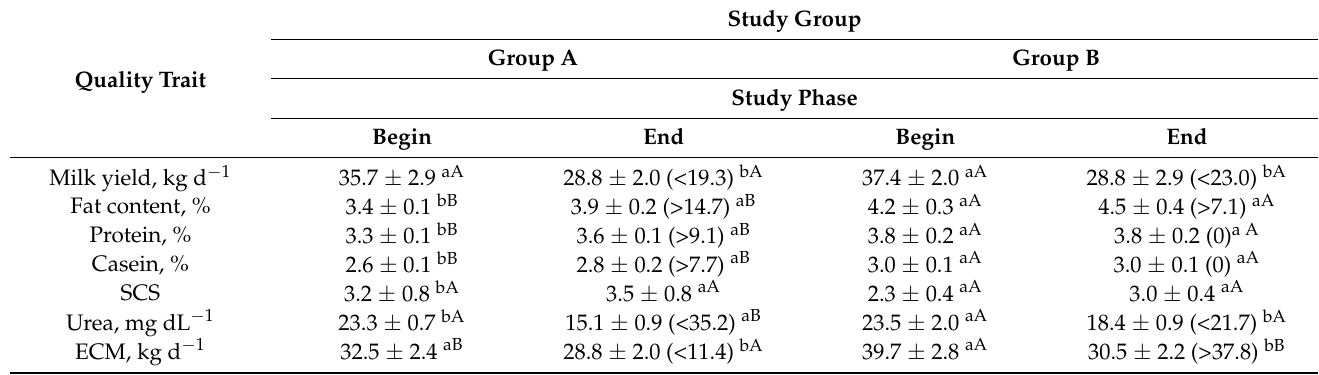
Table 3. Average lactating cow milk productivity, milk quality traits, and energy-corrected milk values between the study group and